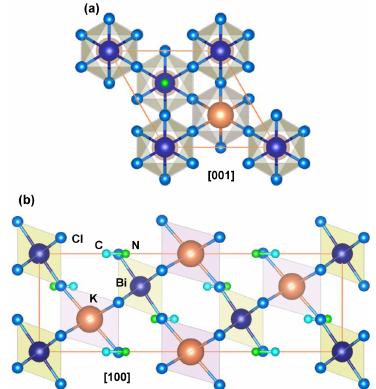
Figure 25: Structural models of (CH 3 NH 3 ) 2 KBiCl 6 double perovskite structures observed along (a) [001] and (b) [100].